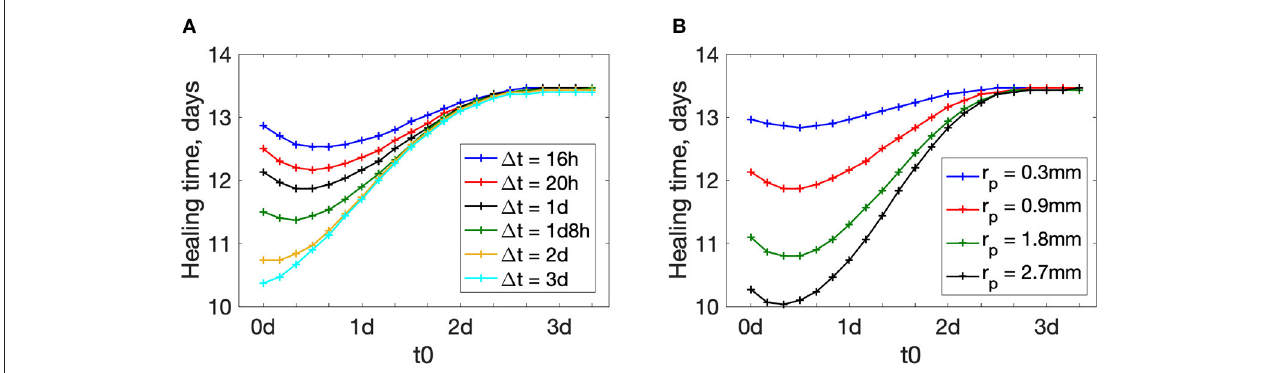
FIGURE 4 | Wound healing time dependence on the treatment beginning time t 0 . (A) plots for different treatment durations 1 t , r p = 0.9 mm. (B) plots for different actuator positions r p , 1 t = 1 day.